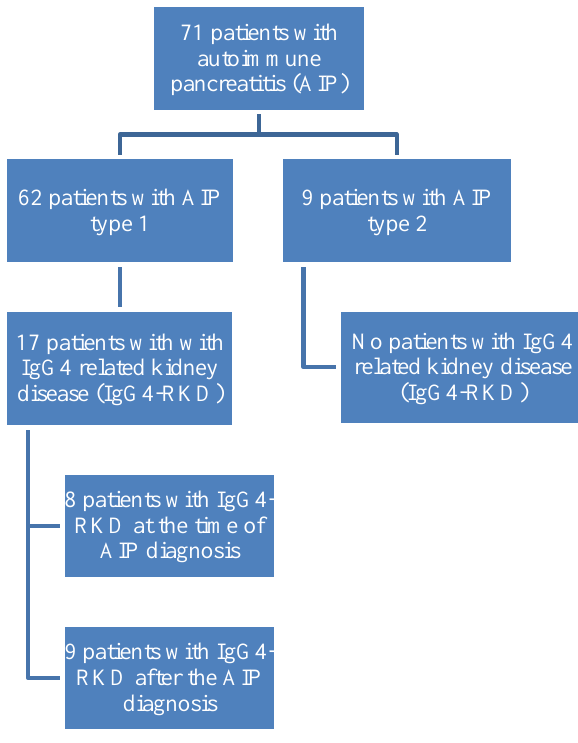
Figure 2. Flowchart of patients.